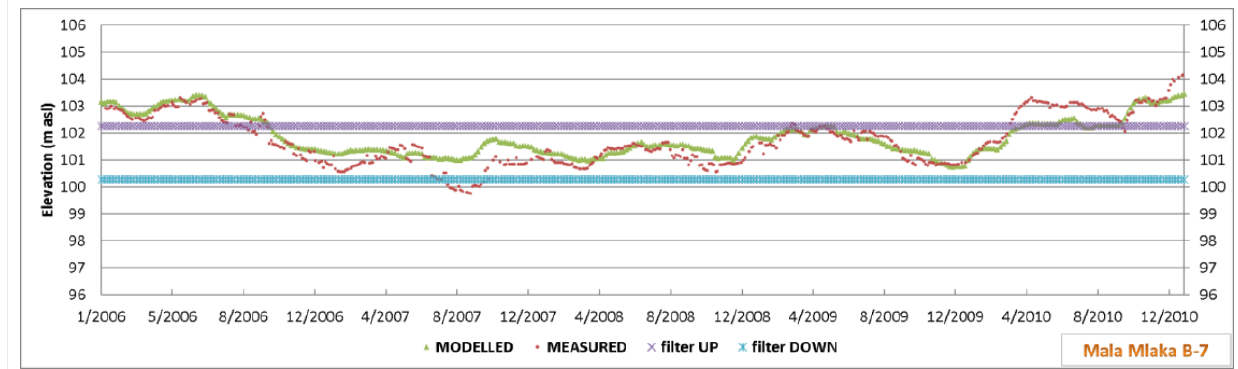
Figure 11. Relationship of measured and modeled groundwater levels with the position of the filter structure of exploitation dug well B-7.